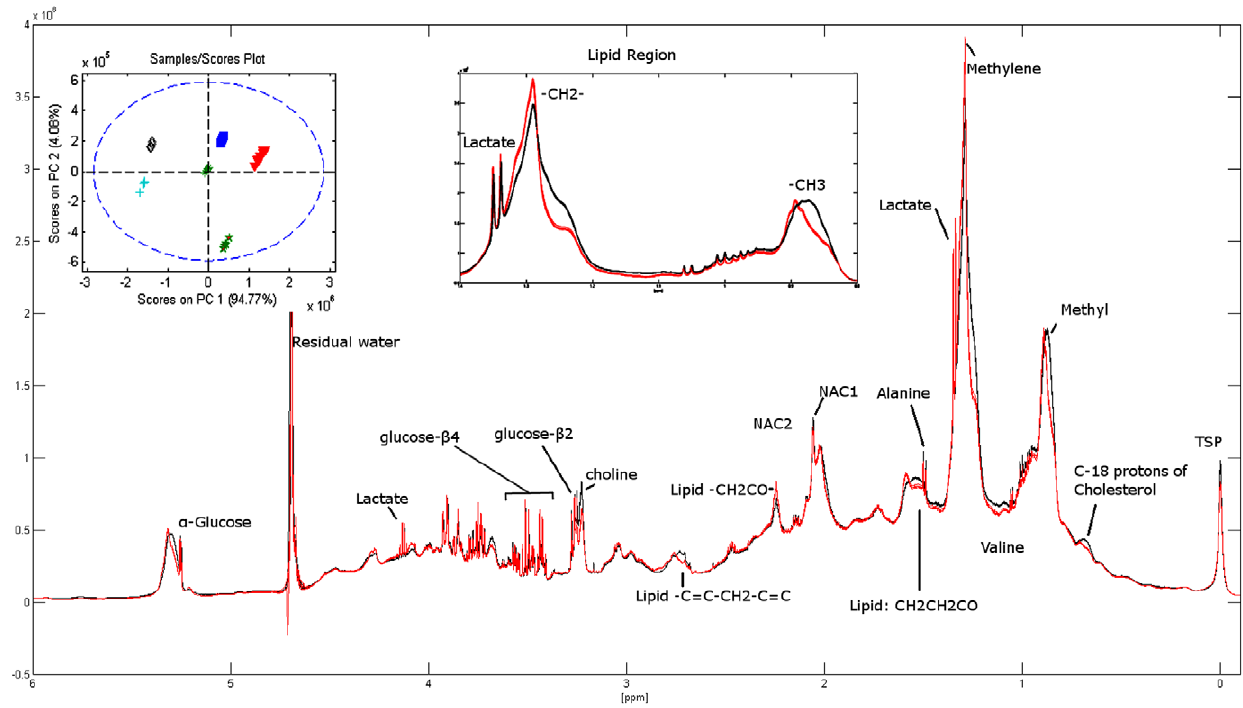
Figure 3. Representative 1 H NOESYGPPR 1D spectra with assignments of the main metabolites. The spectra in red (and black) consist of 5 spectra (superimposing) from two of the subjects. The reproducibility was evaluated by PCA and the score plot shows the spectra from all 6 subjects, clearly depicting larger inter subject variance compared to intra subject variance. NACl and NAC2 refer to composite acetyl signals from a 1- acid glycoprotein. PCA: Principal Component Analysis.